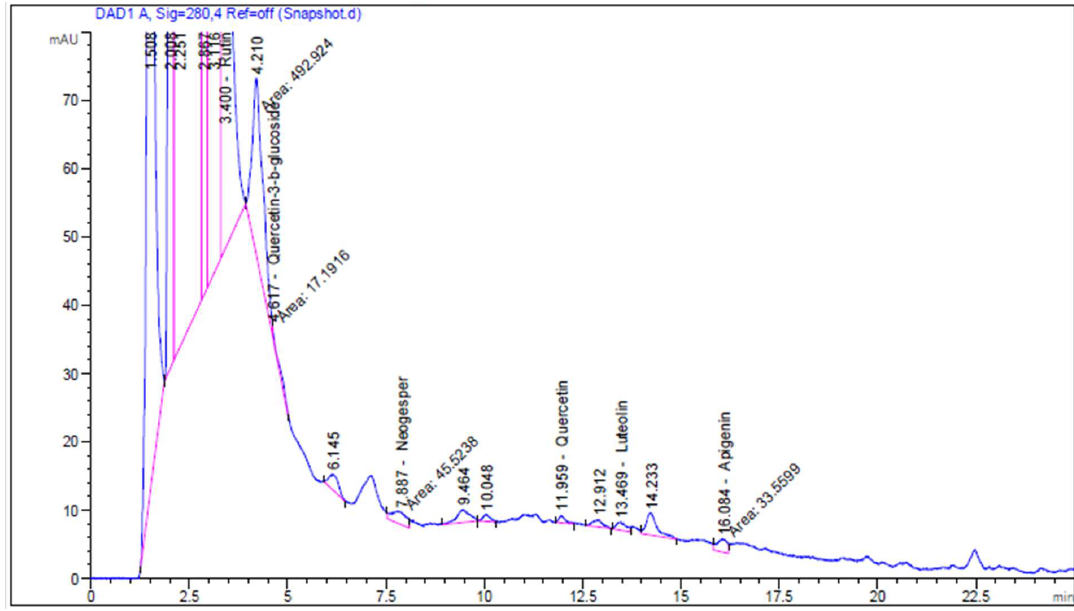
Fig. 2. Chromatogram of flavonoids of red oak leaves and